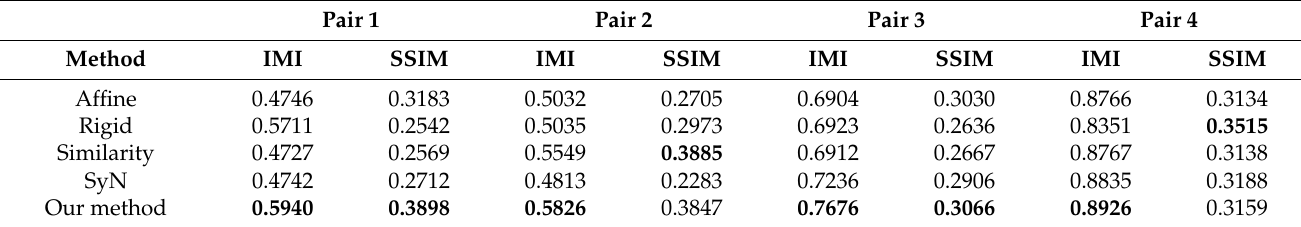
Table 2. Quantitative comparison of different methods according to IMI and SSIM metrics. The best results are shown in